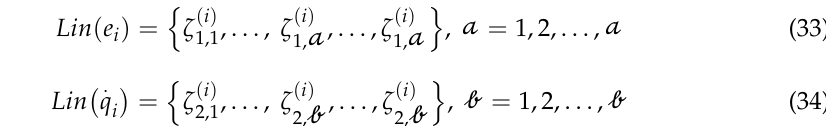
Figure 2. Membership function of fuzzy input of the 𝑖 (cid:3047)(cid:3035) subsystem. The parameters of membership function shown in Figure 2 are defined as follows: